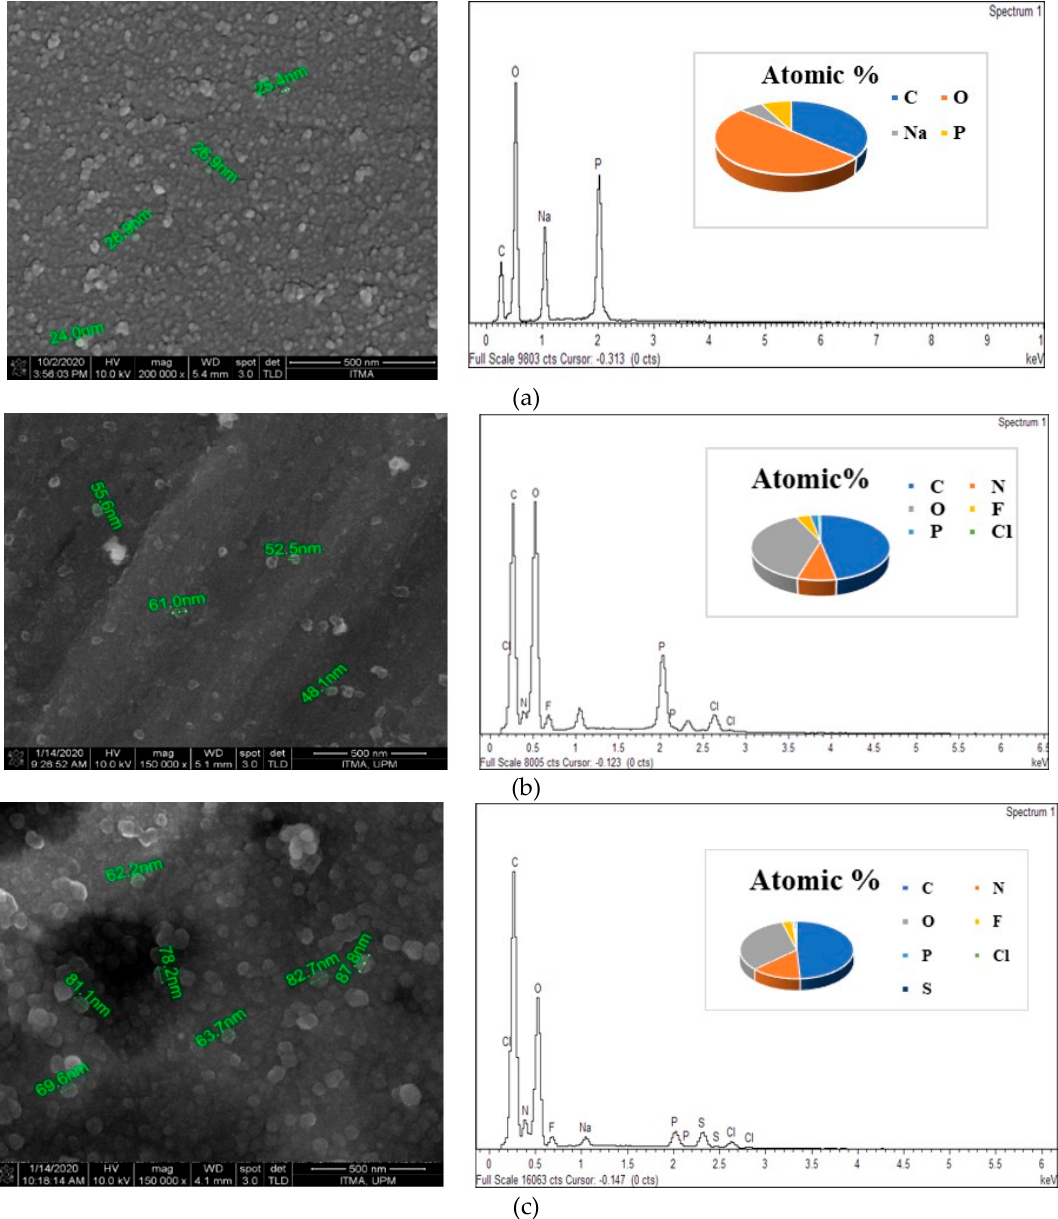
Figure 7. FESEM images and EDX spectrum of ( a ) CS-NPs, ( b ) SF-CS nanoparticles, ( c ) SF-CS-FA nanoparticles.